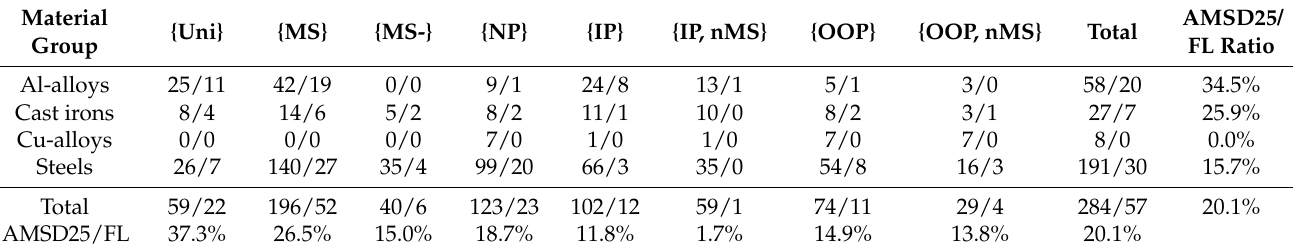
Table 1. The structure of the whole FatLim benchmark set and of the AMSD25 data set. The number before the slash refers to the number of items of the group in the full FatLim data set, while the number of items in the AMSD25 data set is behind the slash. Abbreviations: Uni—uniaxial loading, MS— involves mean stresses, MS—involves compressive mean stresses, NP—non-proportional